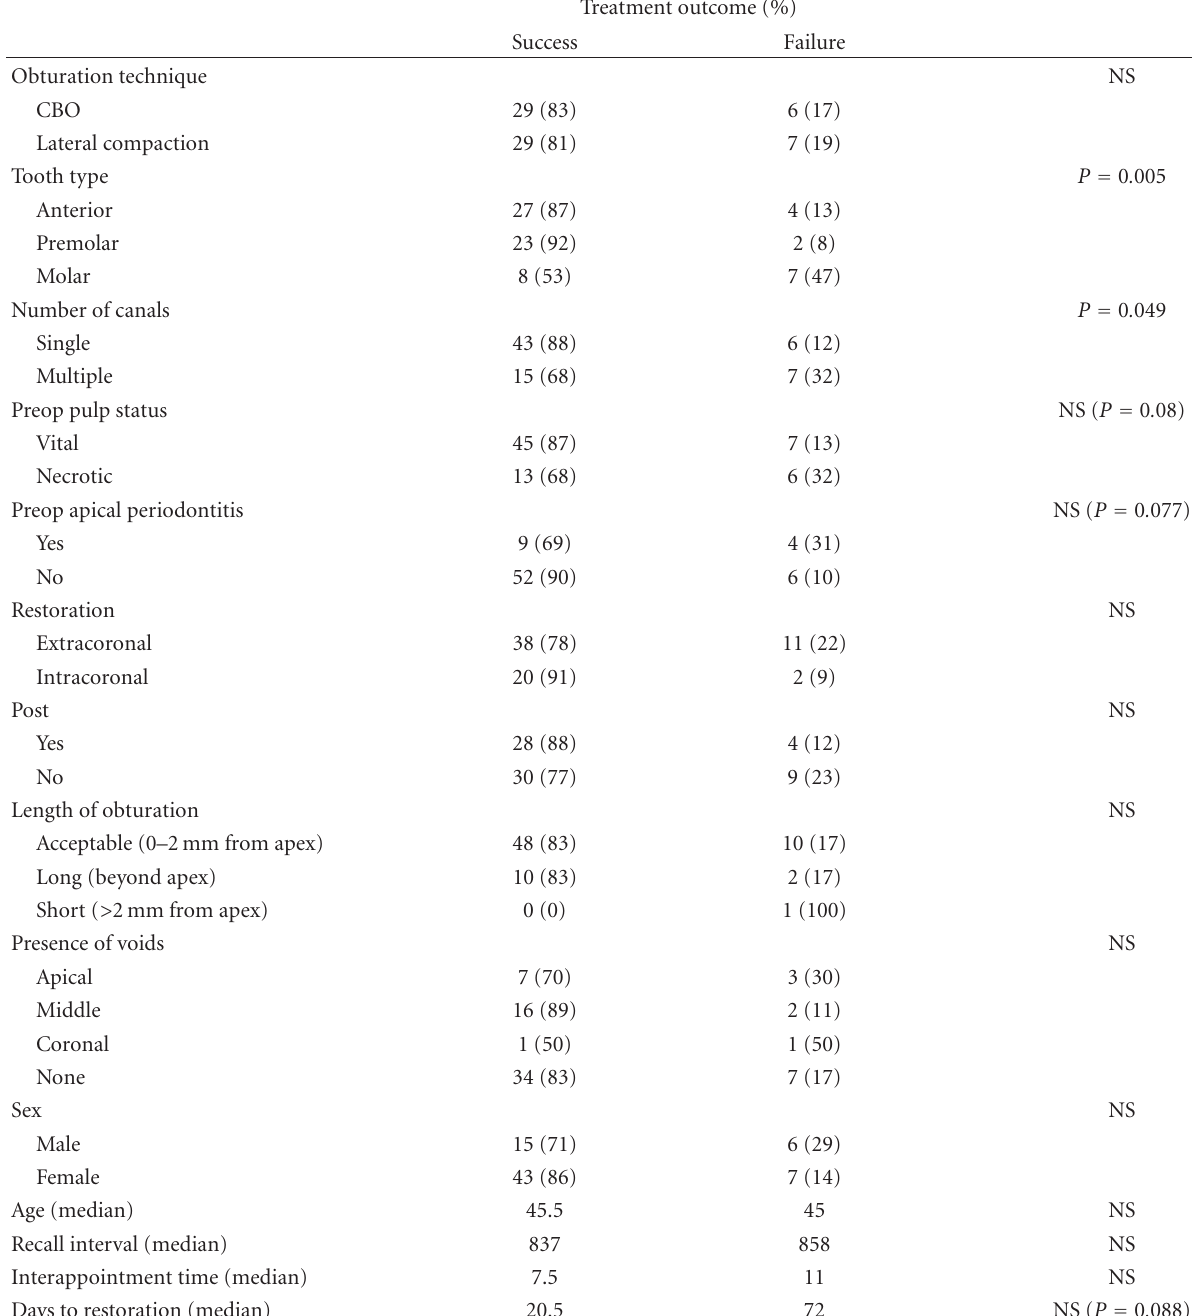
Table 3: The e ff ects of treatment variables on outcome.